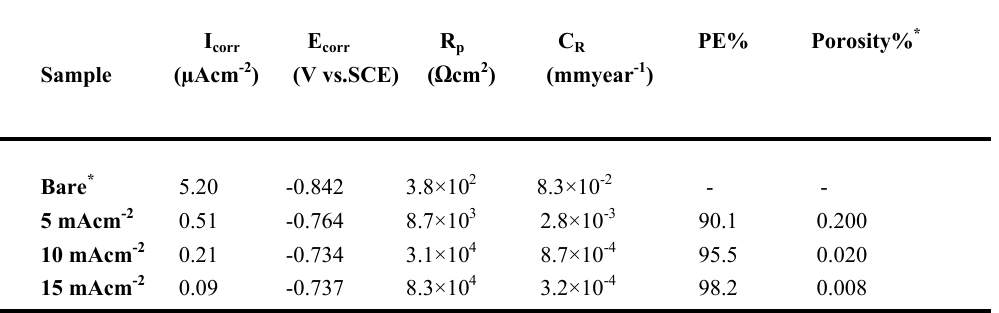
nanocomposite on AA3004 in aqueous 2